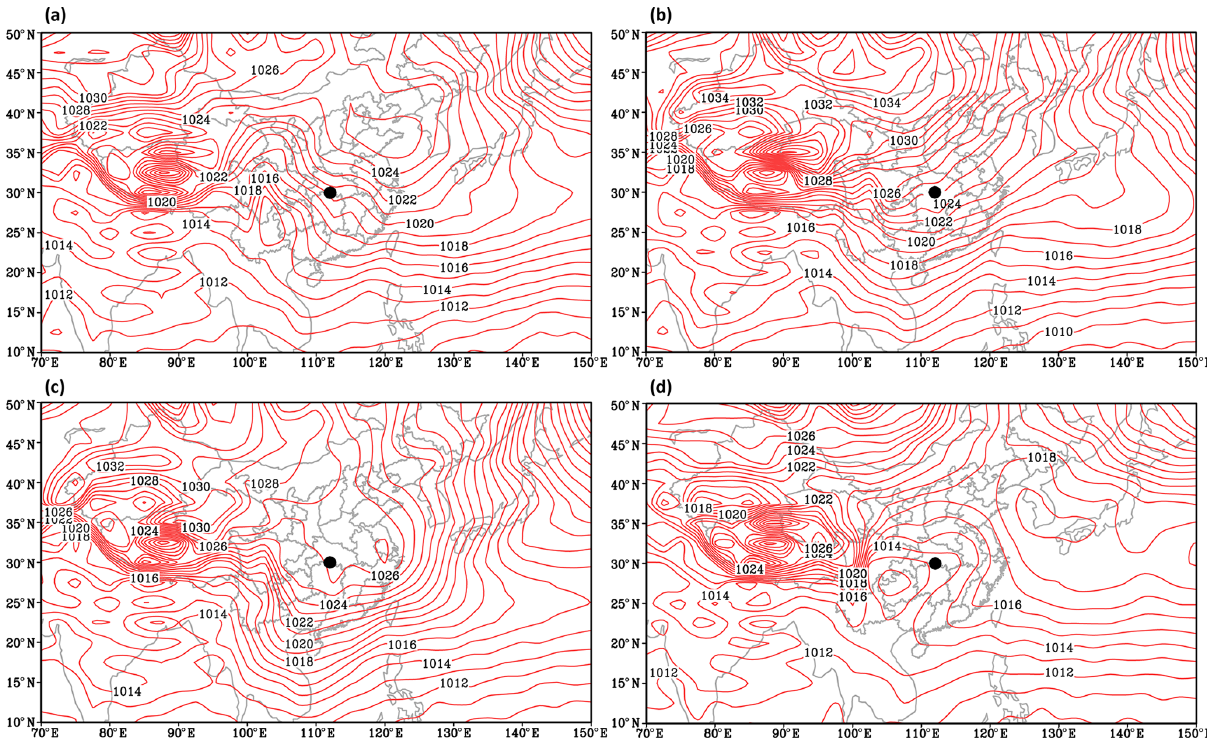
Figure 4. Spatial distribution of sea level pressure for SW-type (a) , NW-type (b) , A-type (c) , and C-type (d) synoptic control averaged over 2013–2018. The black dot indicates the location of Jingzhou.